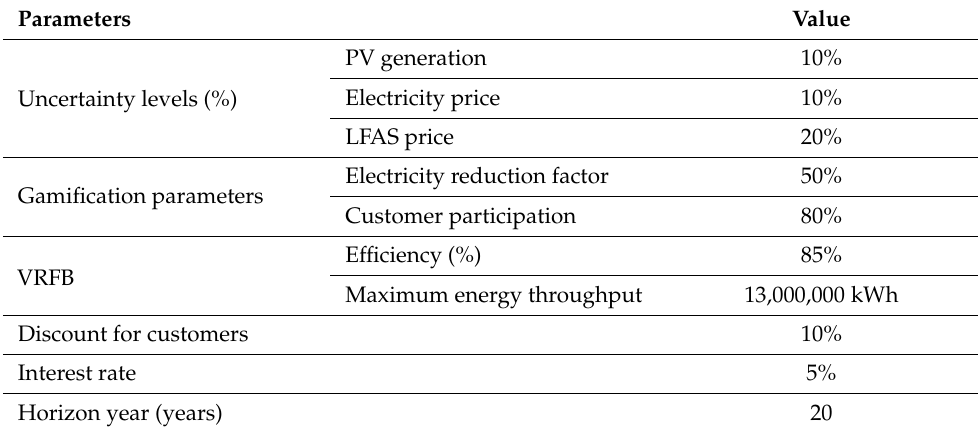
Table 2. Input parameters for simulations.